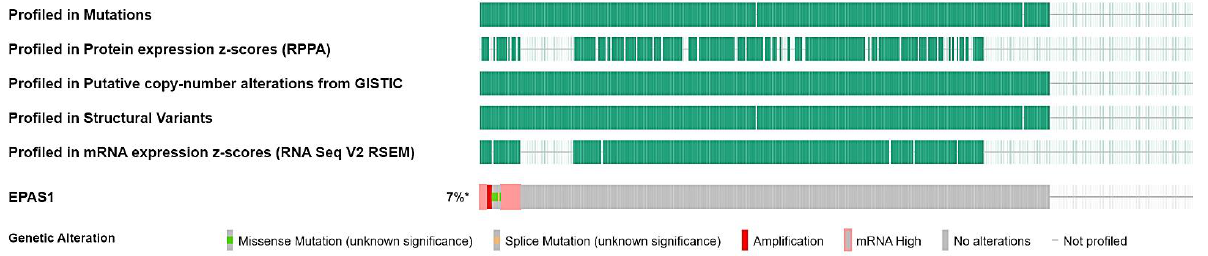
Figure 2. Oncoplot of EPAS1 molecular alterations in MSK/TCGA 2020 cohort ( n = 476). * altered/profiled: 27/380.